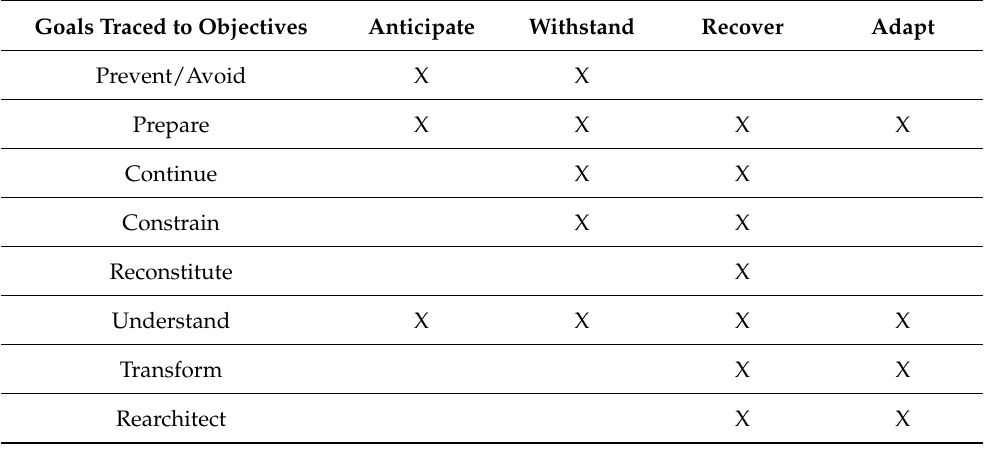
Goals Traced to Objectives Anticipate Withstand Recover